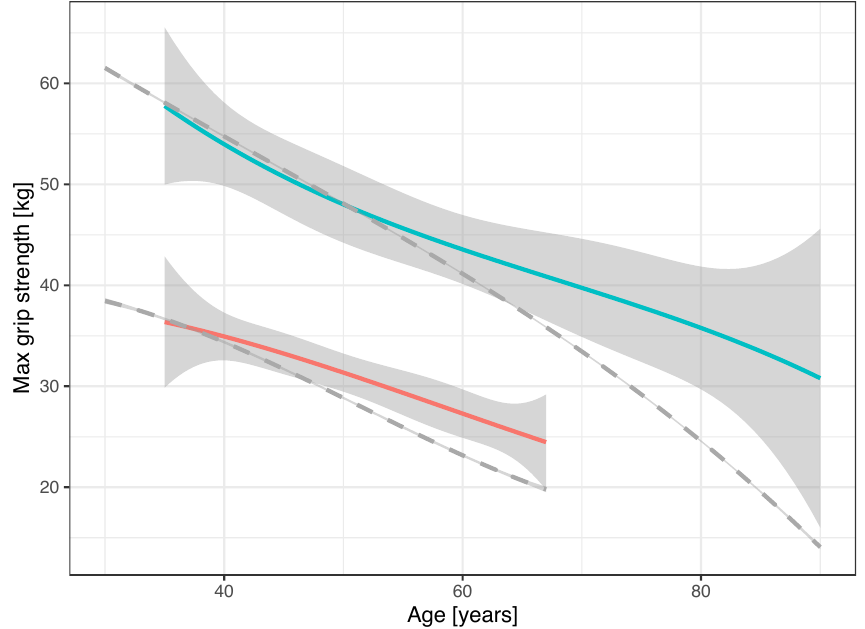
Figure 1. Age-associated decline in GS and weightlifting performance (adjusted for body mass). Figure legend: females—red; males—green. Dashed lines are the dimensionless age factors for performance decline in weightlifting from SMF/SHMF, adjusted to have a comparable intercept with the GS curves.